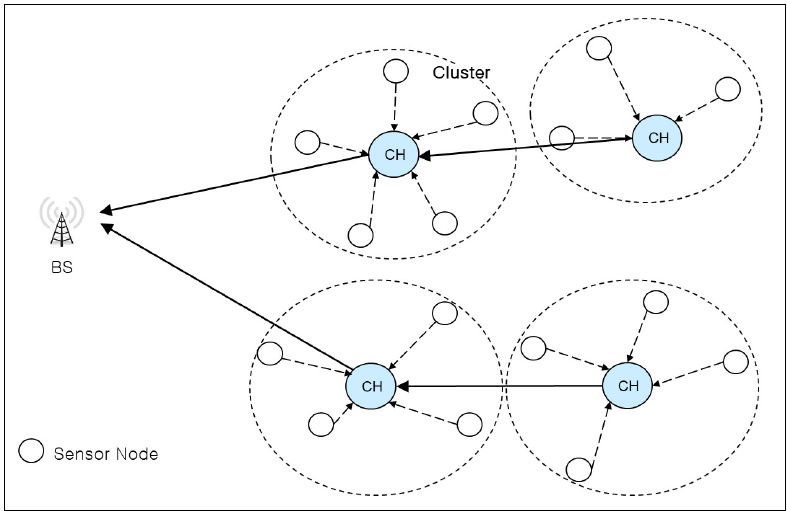
Figure 6. Steady-State phase of a multi-hop LEACH